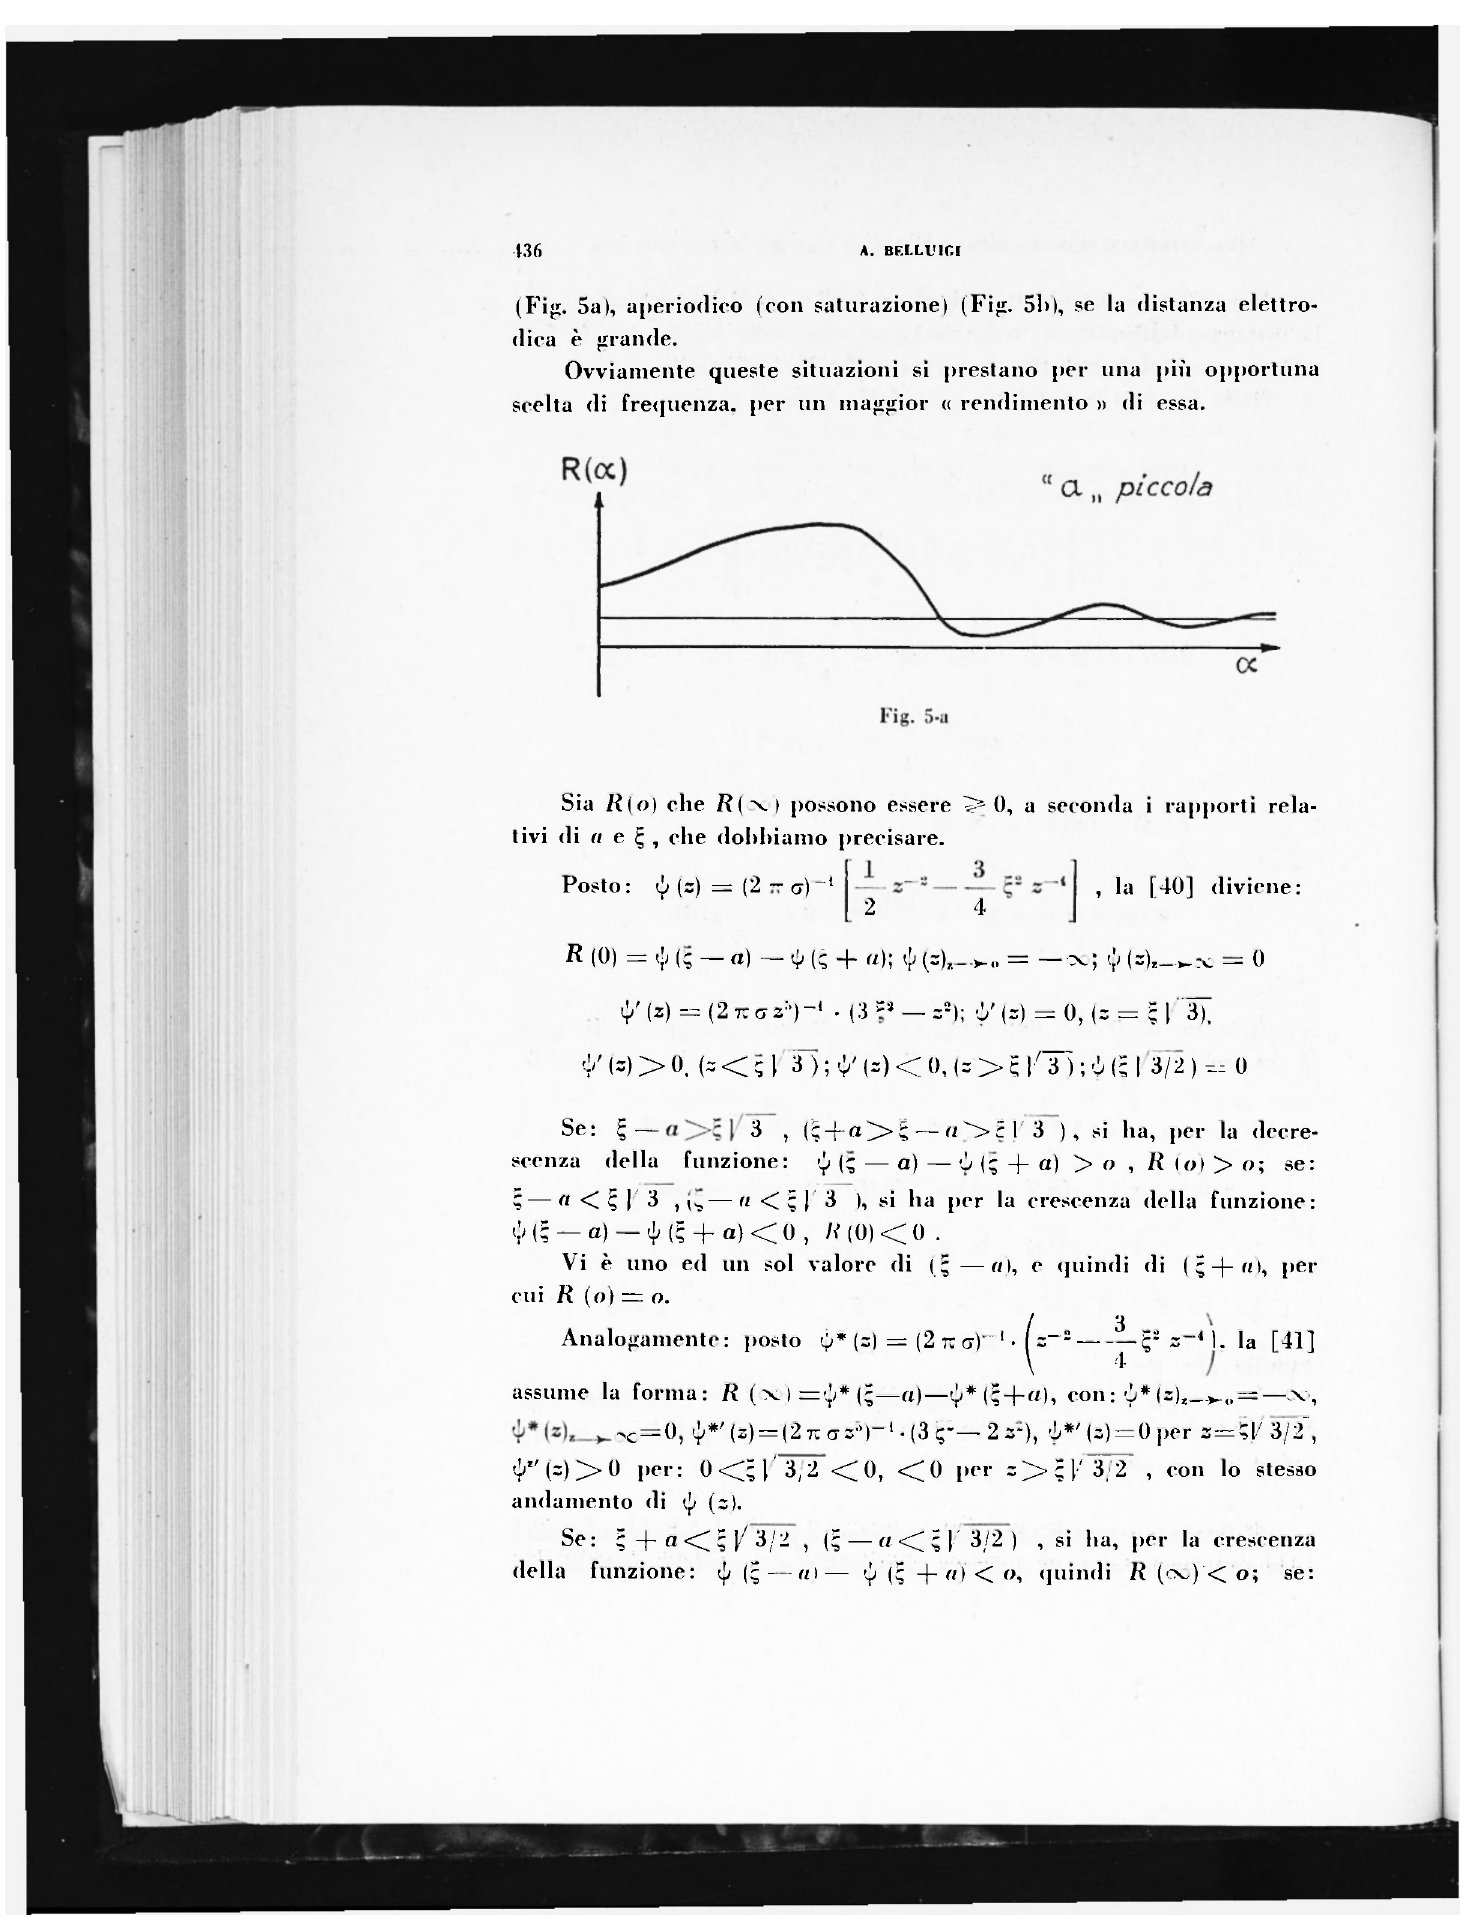
(Fig. 5a), aperiodico (con saturazione) (Fig. 51»), se la distanza elettro- dica è